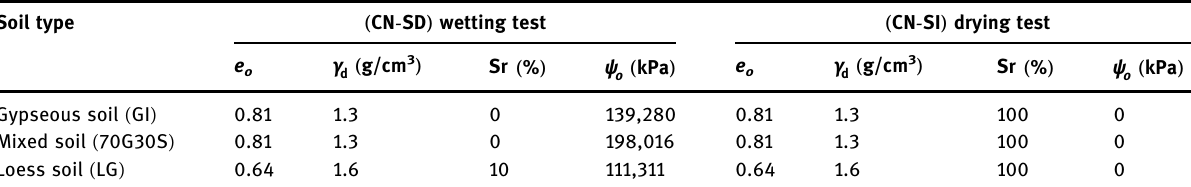
Table 2: Initial conditions of the soil samples and the boundary conditions of the test Soil